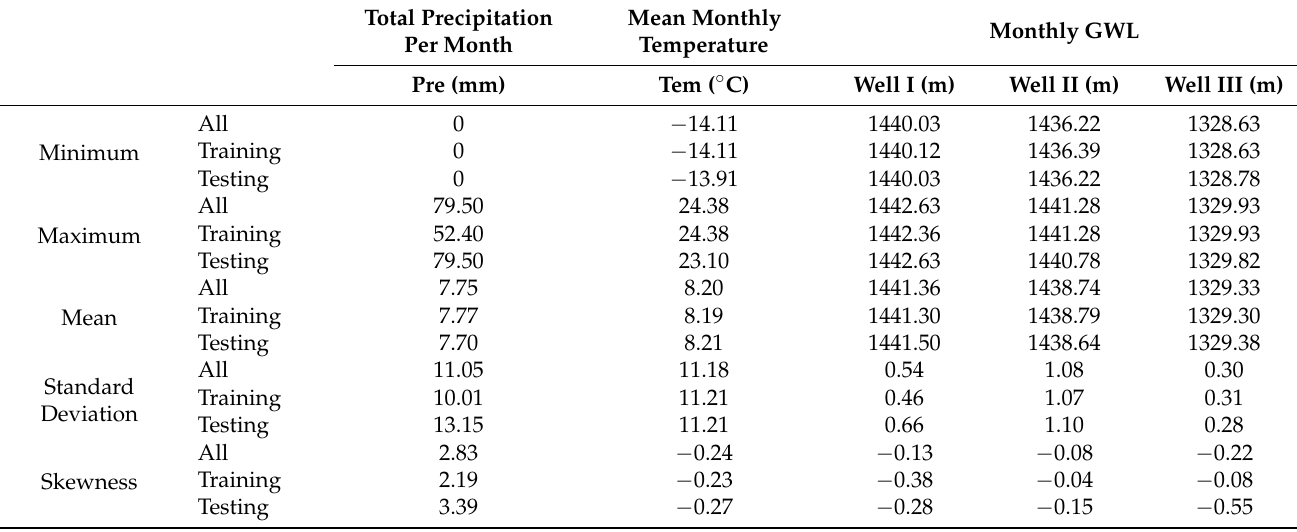
Table 2. The statistical parameters of groundwater level (GWL) and related climatic data for three GWL observation wells in the whole dataset (January 2000 to December 2015), the training dataset (January 2000 to December 2010) and the testing dataset (January 2011 to December